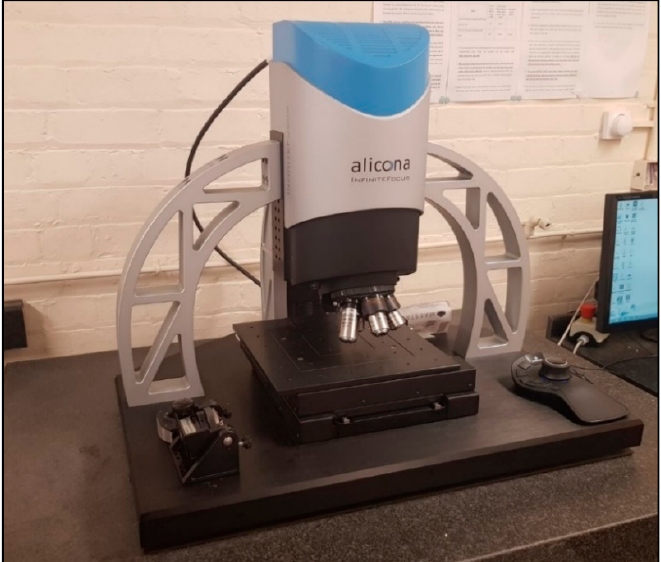
Figure 4. The Focus Variation 3D microscope, Alicona Infinite Focus G5.